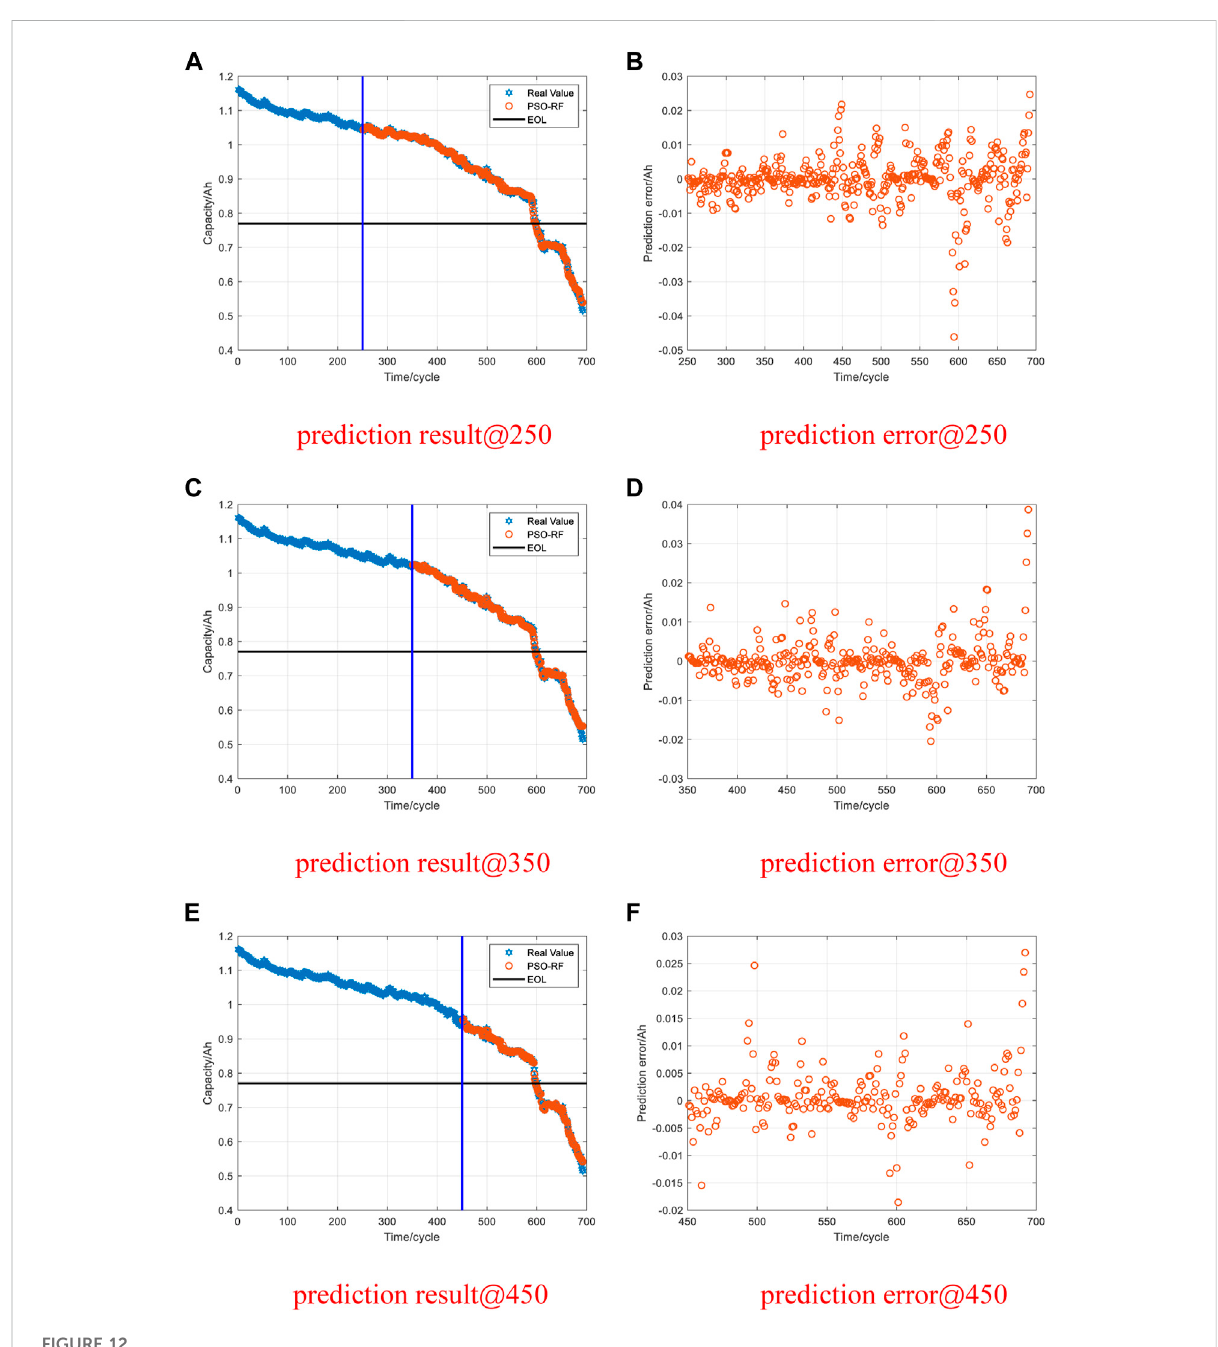
FIGURE 12 Results and errors of CS2-33